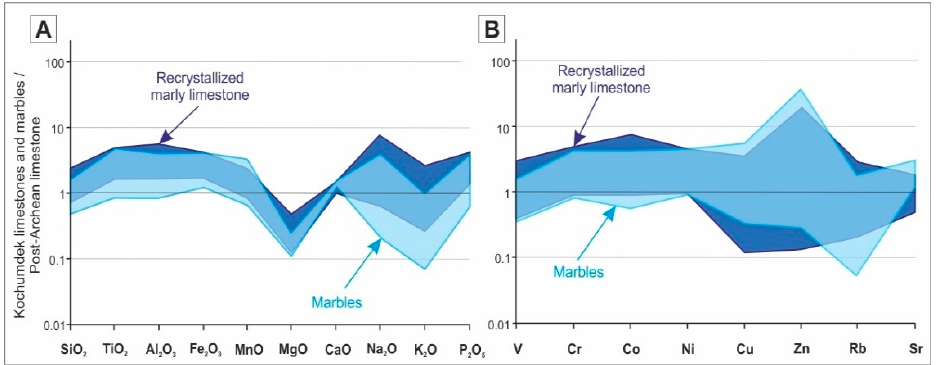
Figure 6. Major ( A ) and trace element ( B ) patterns for recrystallized marly limestones and marbles from the Kochumdek aureole, normalized to Post-Archean limestone [60]; based on data from Table 3.